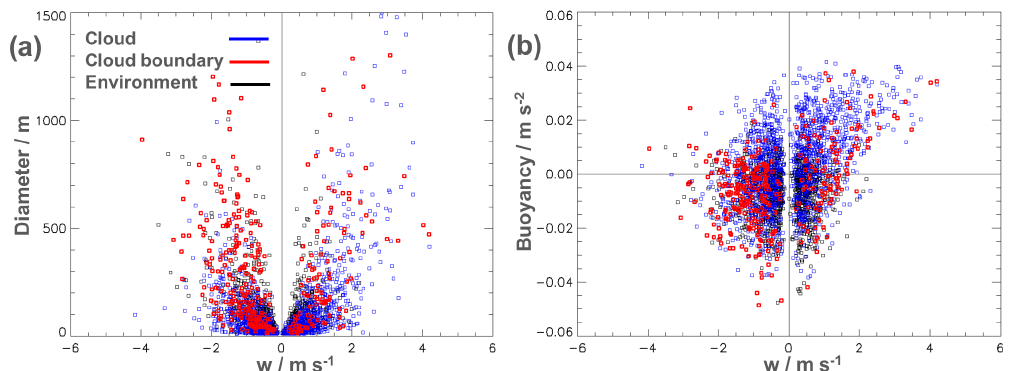
Figure 12. (a) Scatterplot of median vertical velocities ( w ) and diameters for the up- and downdraughts in the cloud at the cloud boundary and the environment. Each point represents one individual draught. (b) Same for the median vertical velocities ( w ) and buoyancy.